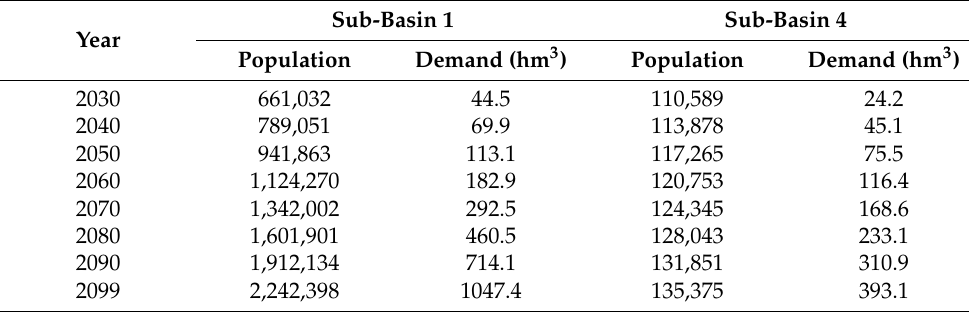
Figure 9. Projected population demand (2010–2099). Table 8. Annual population demand in the VUB region.